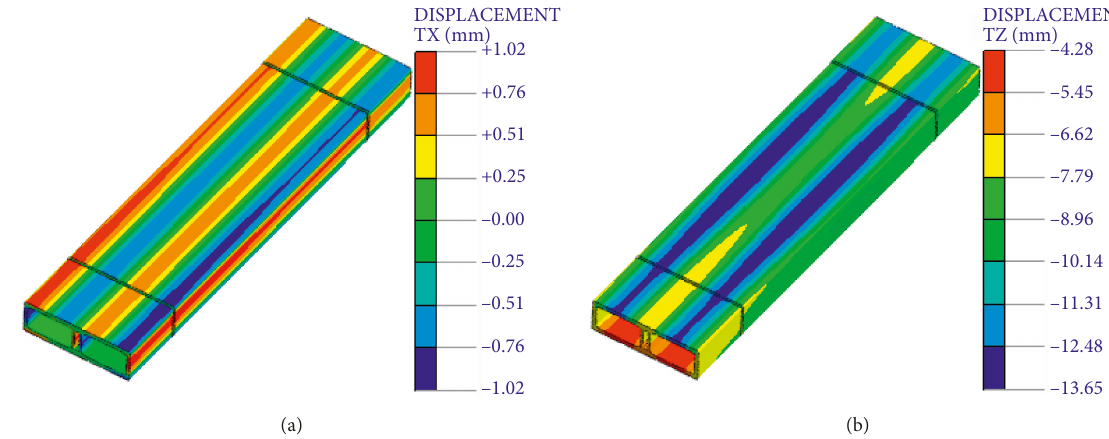
Figure 9: The displacement nephogram under working condition 2: (a) horizontal displacement; (b) vertical displacement.